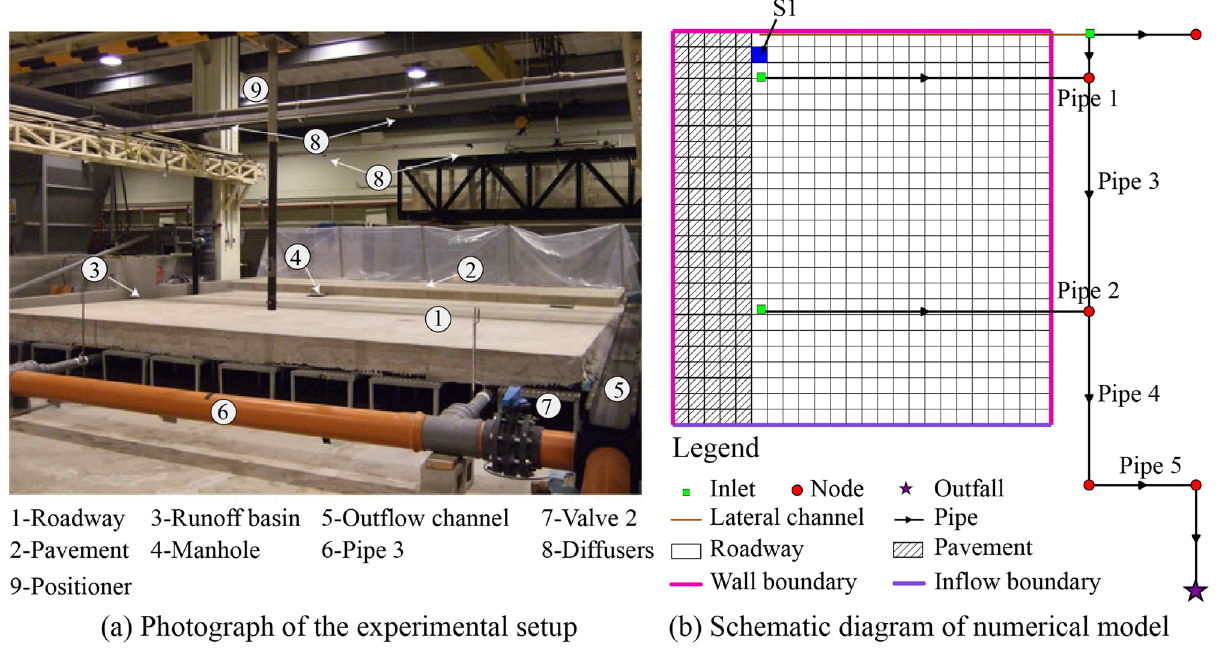
Figure 3. Model construction and configuration for analyzing the drainage model ( a ) Experimental flume 35 .